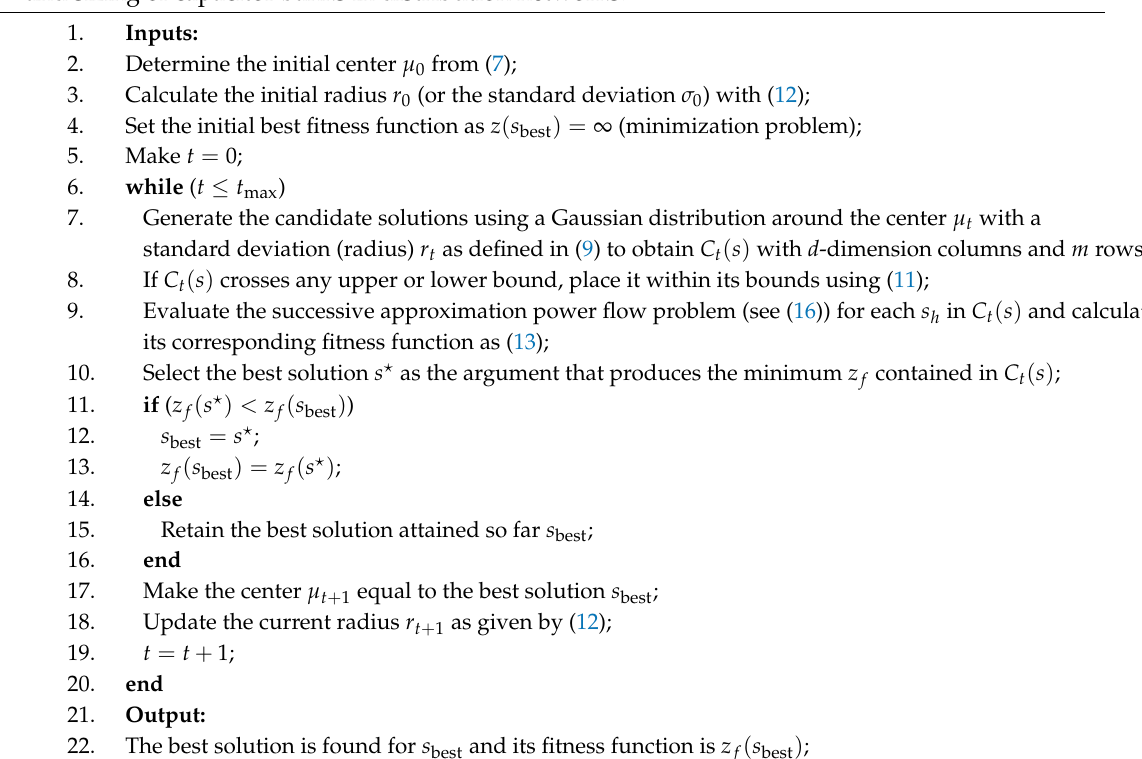
Algorithm 1: Proposed master optimization algorithm based on the VSA to define the location and sizing of capacitor banks in distribution